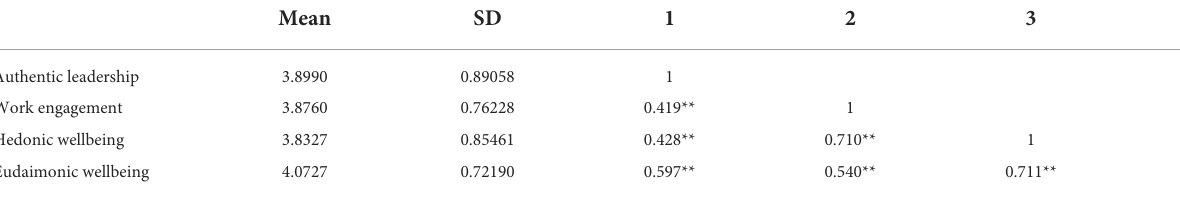
TABLE 1 Descriptive statistics, mean, standard deviation (SD), and correlation of the variables.